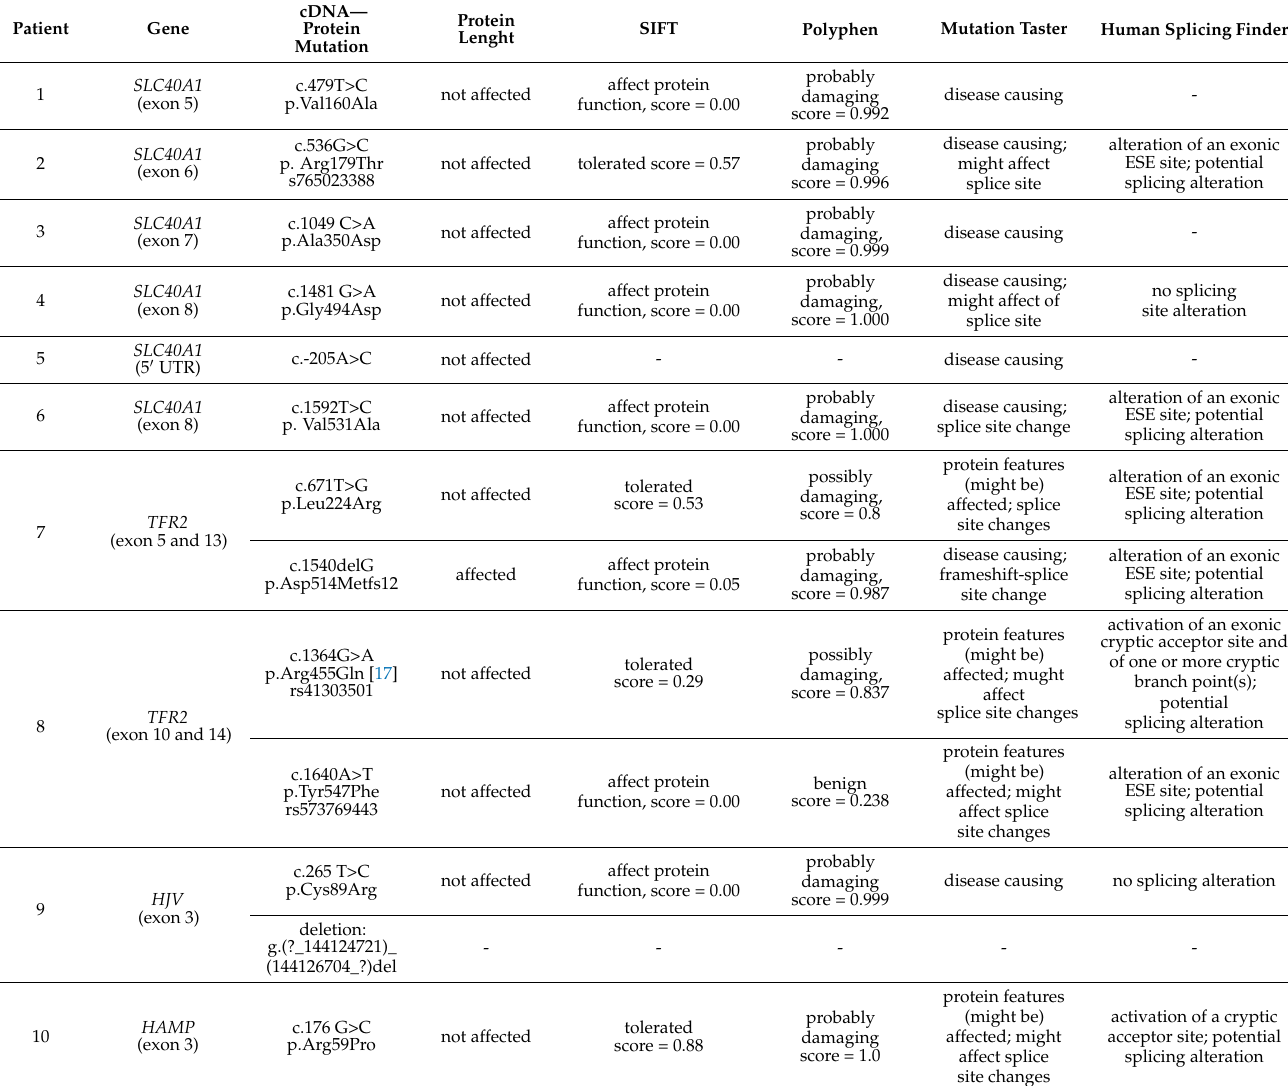
Table 4. In silico prediction of mutations’ effect on protein